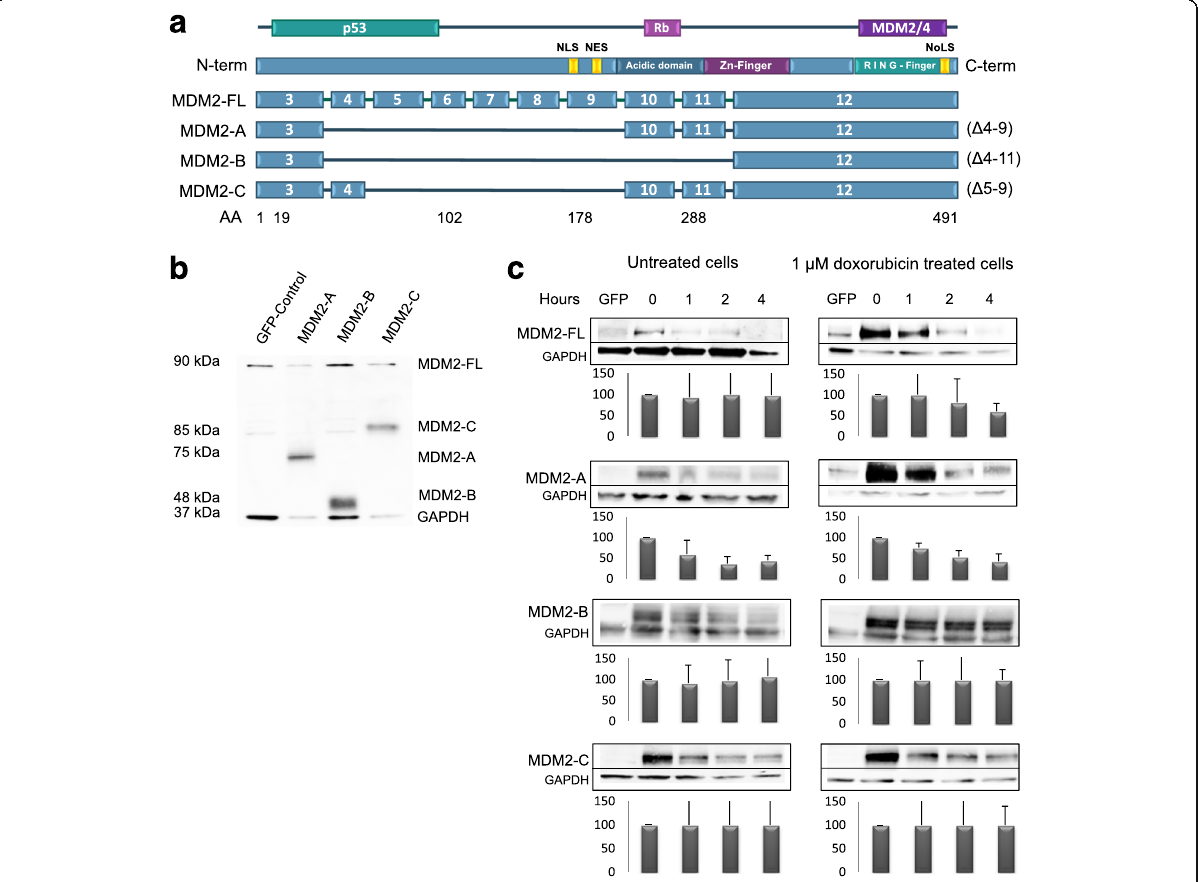
Fig. 1 ( a ) Schematic representation of MDM2 and the splice variants MDM2-A, -B and -C. MDM2 consists of 491 amino acids. Localization of the p53, pRb and MDM2/4 binding sites, NLS, NES, NoLS, the acidic domain, the Zn-finger domain and the RING-finger domain are indicated, as well as the exon distribution. ( b ) Validation of protein expression. MCF-7 breast cancer cells transfected with pCMV-GFP control (GFP-control), MDM2-A (75 kDa), -B (48 kDa) and -C (85 kDa) analyzed 24 h post transfection. GAPDH was used as loading control. Primary antibodies were Anti-MDM2 (N-20) Sc-813 (Santa Cruz) and GAPDH (SantaCruz). ( c ) Protein stability of the expressed splice variants. MCF-7 cells transfected with MDM2-FL, MDM2-A, -B and -C at 0, 1, 2 and 4 h post cycloheximide treatment, respectively. In addition to cycloheximide treatment, left panel shows cells without doxorubicin treatment, right panel shows cells treated with 1 μ M doxorubicin for 24 h. Primary antibodies Anti-MDM2 (N-20) Sc-813 (Santa Cruz) and GAPDH (SantaCruz). Histograms under immunoblots represent averages of triplicate experiments and show levels of the MDM2-variants relative to GAPDH-levels for each